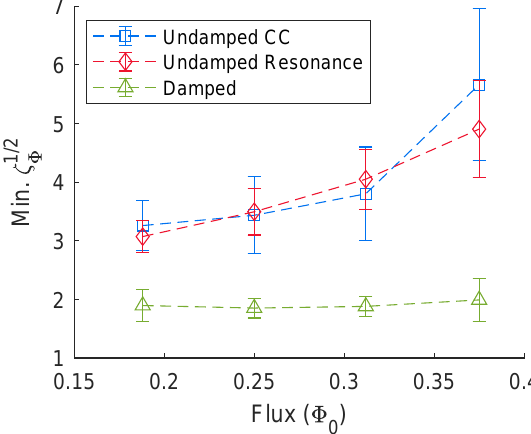
Figure 8. Minimum flux noise for damped vs. undamped SQUIDs. The square blue symbols correspond to the undamped SQUID along the critical curve, the diamond red symbols are for the undamped SQUID along the first resonance, and the triangular green symbols correspond to the damped SQUID along the critical curve. These data were generated by varying the current ( I ) at fixed